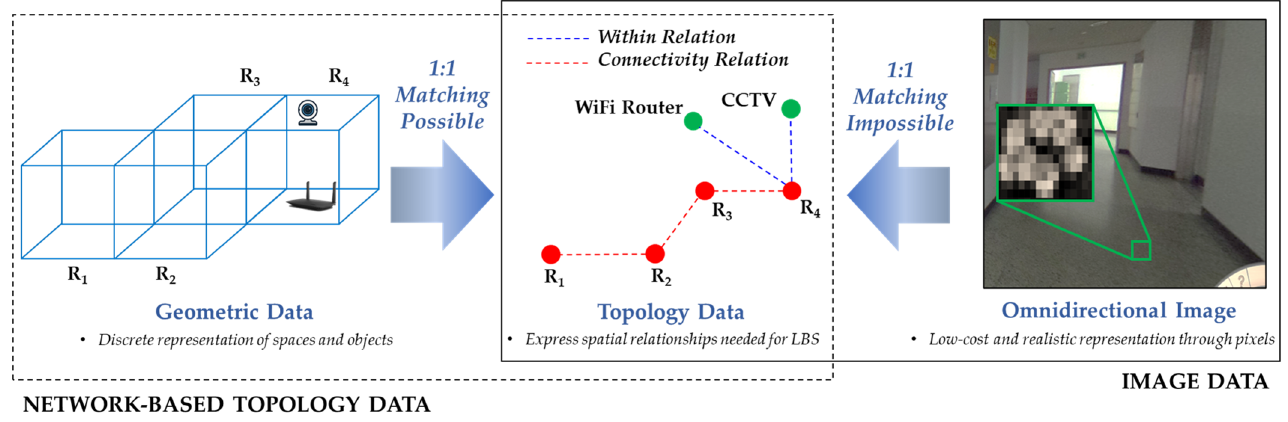
Figure 3. The difficulty of expressing topological relationships on the image data made of pixels.